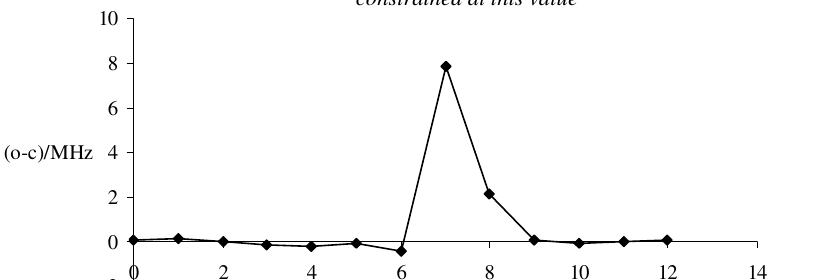
Fig 1. Differences between observed and calculated rotational frequencies of Figure 1 CH 3 CN for v 4 = 1 state .